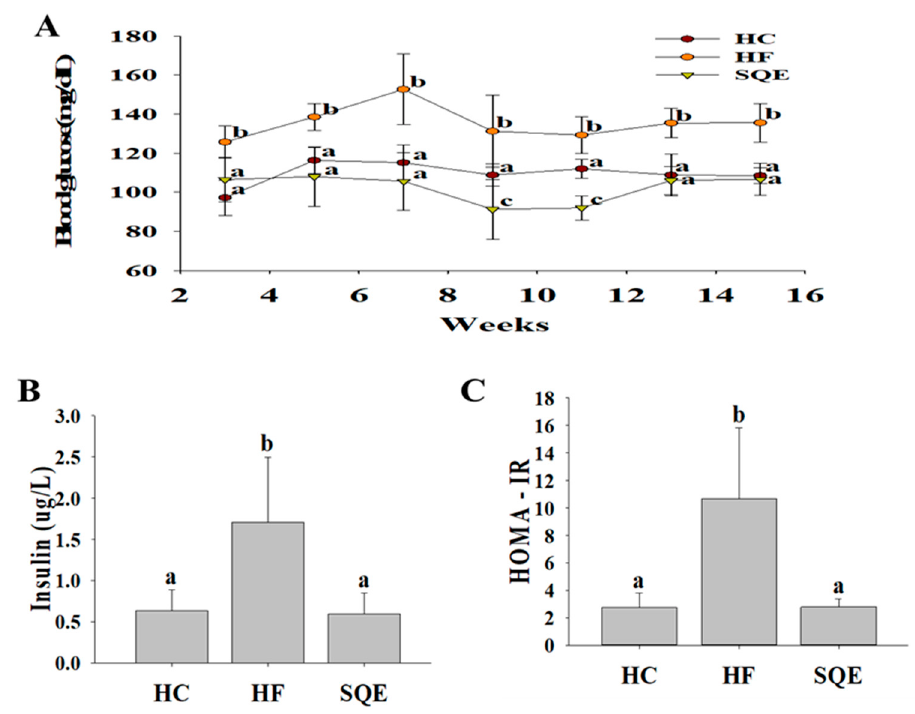
Figure 2. Effect of SQE supplementation on glucose homeostasis in HF-diet-fed rats: ( A ) Fasting blood glucose profile over 16 weeks; ( B ) serum insulin levels after 16 weeks; ( C ) HOMA-IR index after 16 weeks. Data are given as mean ± SD ( n = 7). Different letters in each assay indicate significant differences among the HC, HF, and SQE groups by Tukey’s multiple range test ( p < 0.05). HC, 46% carbohydrate diet; HF, 60% fructose diet; SQE, 60% fructose diet with SQE (500 mg/kg of BW) in drinking water. BW, body weight; HC, high-carbohydrate-diet-fed rats; HF, high-fructose-diet-fed rats; SQE, the high-fructose-diet-fed rats supplemented with S. quelpaertensis leaf extract; HOMA-IR, homeostasis model assessment of insulin resistance.